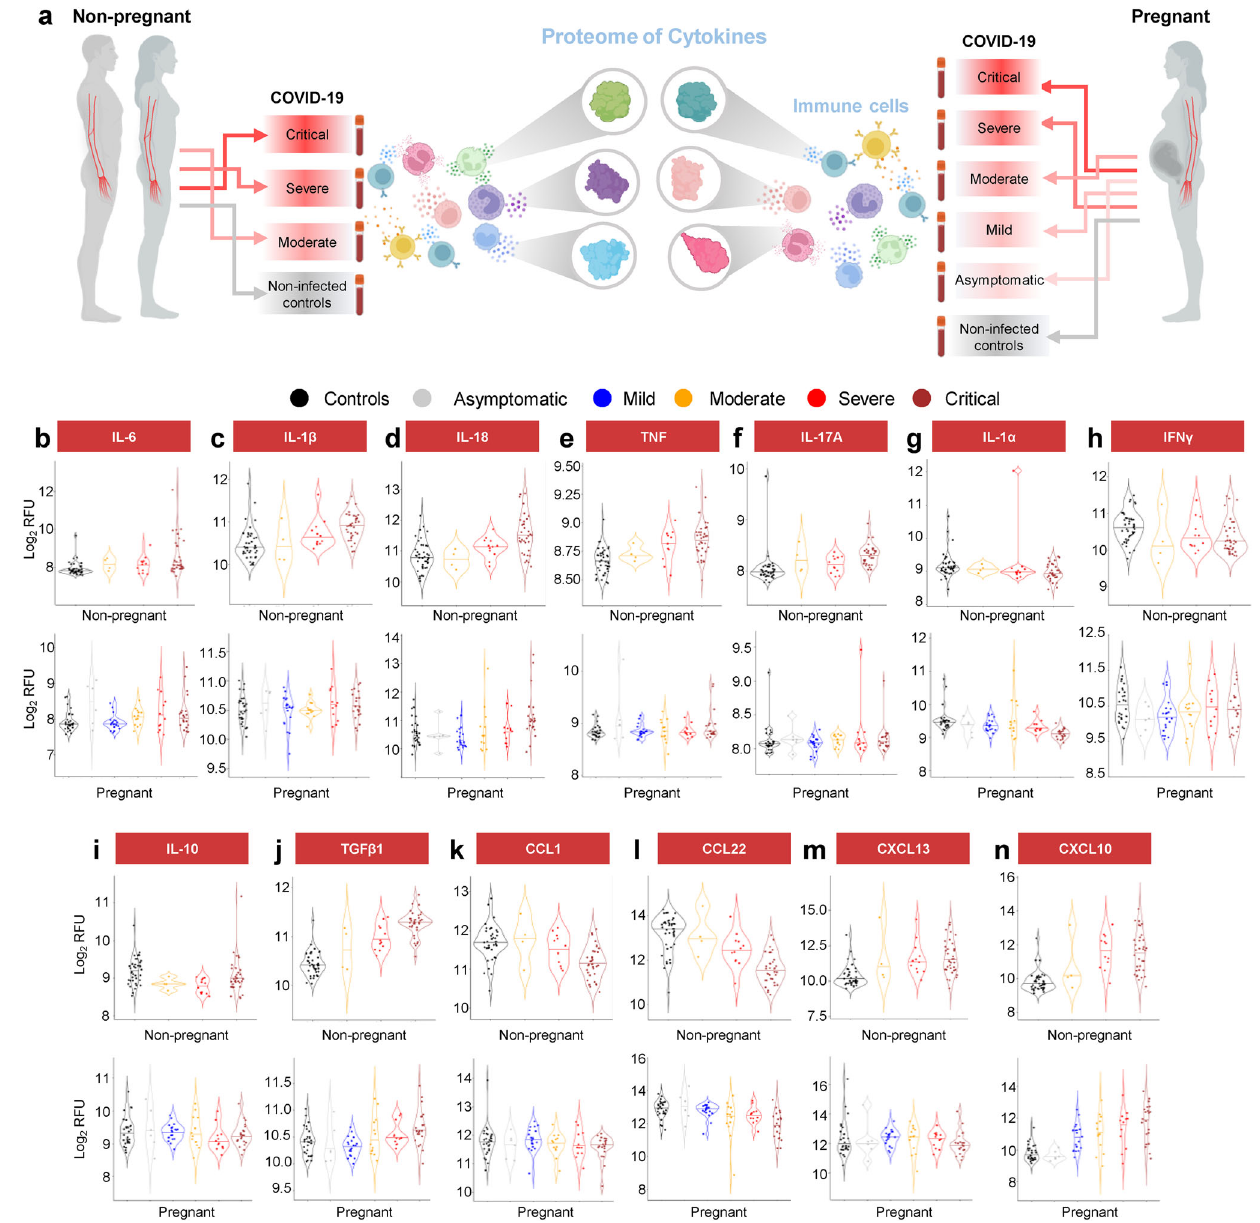
Fig. 7 Pregnant women with COVID-19 display a dampened systemic cytokine response. a Representative diagram illustrating the evaluation and comparison of speci fi c cytokines in the circulation of pregnant and non-pregnant COVID-19 cases and controls. b – n Violin plots showing the modulation of b IL-6, c IL-1 β , d IL-18, e TNF, f IL-17A, g IL-1 α , h IFN γ , i IL-10, j TGF β 1, k CCL1, l CCL22, m CXCL13, and n CXCL10 levels with COVID-19 severity in non- pregnant and pregnant cases and controls. Black = control, gray = asymptomatic, blue = mild, yellow = moderate, red = severe, and brown = critical. RFU = relative fl uorescence